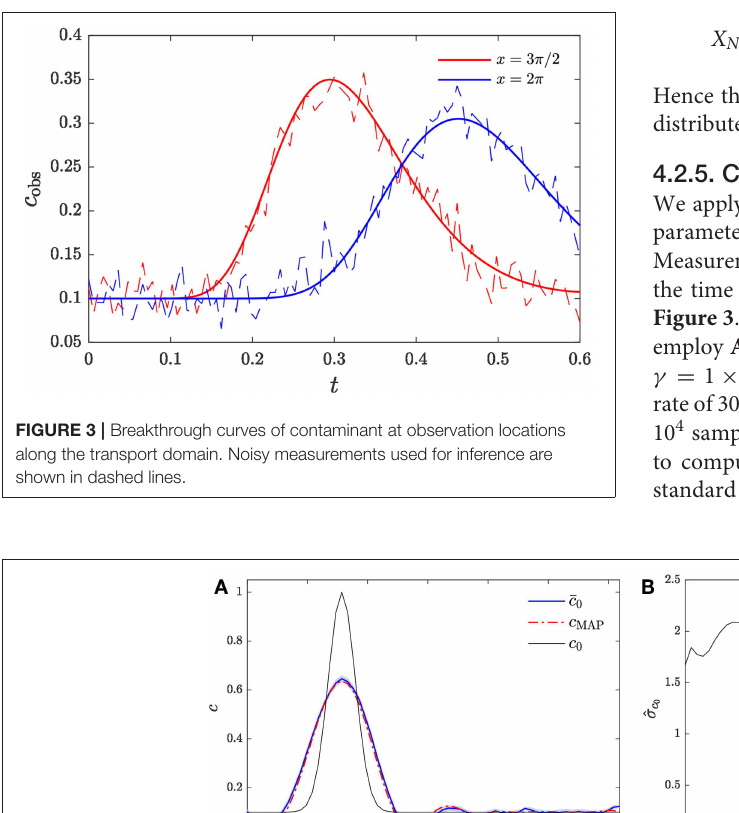
Frontiers in Environmental Science |